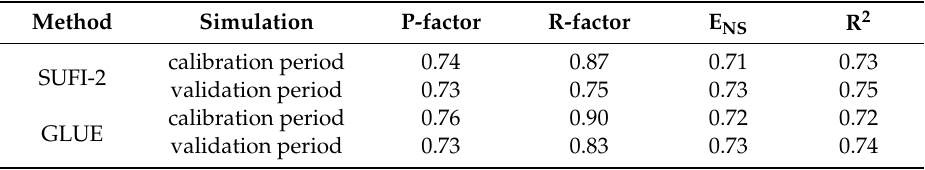
Table 4. Comparison of simulation results from the two methods.